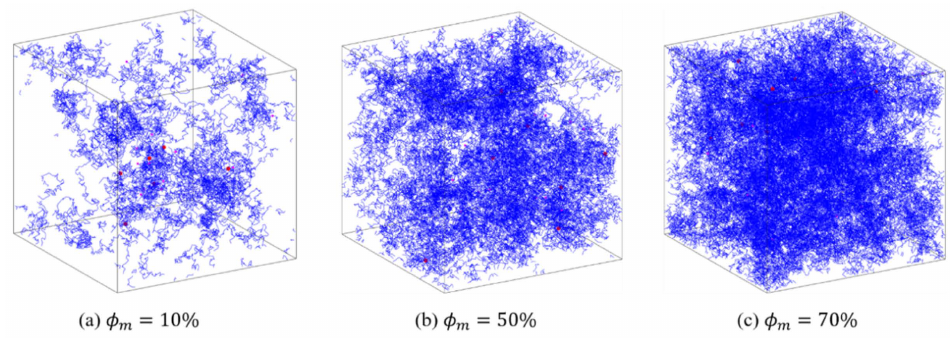
Figure 4. Configurations of PAAm hydrogels generated by SAW network